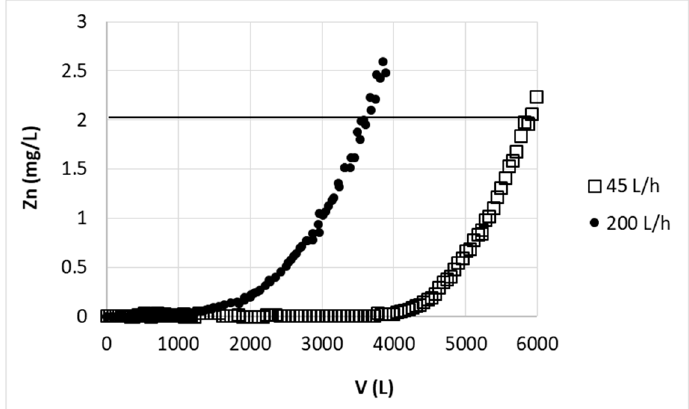
Figure 9. Effect of flow rate on zinc(II) ions removal on hybrid pectin-based biosorbent. Mass of sorbent (dry form, large grain): 16 kg; initial concentration of Zn: 30 mg/L; pH = 6.